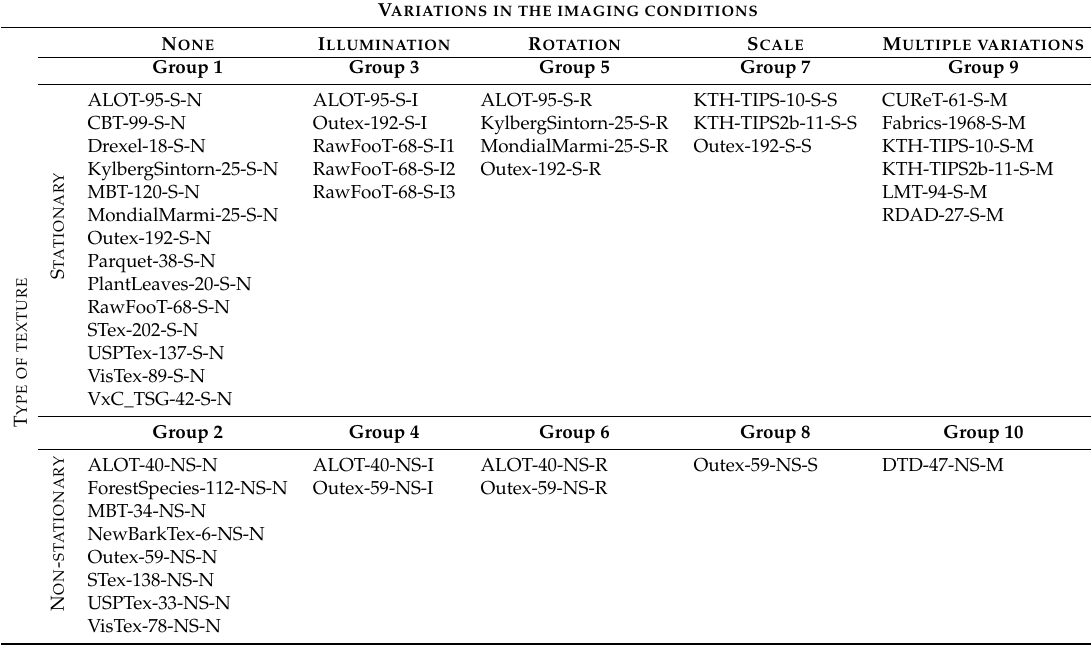
Table 1. Round-up table of the image datasets used in the experiments. ALOT, Amsterdam Library of Textures; CUReT, Columbia-Utrecht Reflectance and Texture Database; CBT, Coloured Brodatz Textures; MBT, Multiband Texture Database; RawFooT, Raw Food Texture Database; VisTex, Vision Texture Database; RDAD, Robotics Domain Attribute Database; STex, Salzburg Texture Image Database; DTD, Describable Texture Dataset; S, Stationary; NS, Non-Stationary; N, No variations; I, variations in Illumination; R, variations in Rotation; S, variations in Scale, M, Multiple